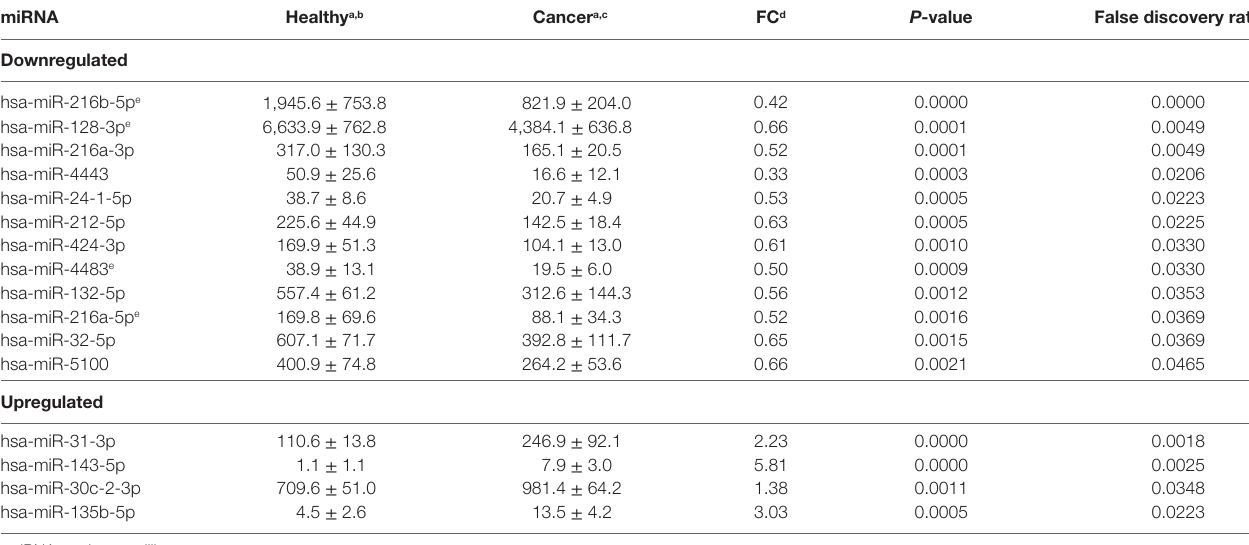
TaBle 3 | List of microRNA (miRNA) differentially expressed between cells treated with head and neck squamous cell carcinomas (HNSCC) patient serum and with normal human serum. mirna healthy a,b cancer a,c Fc d P -value False discovery rate